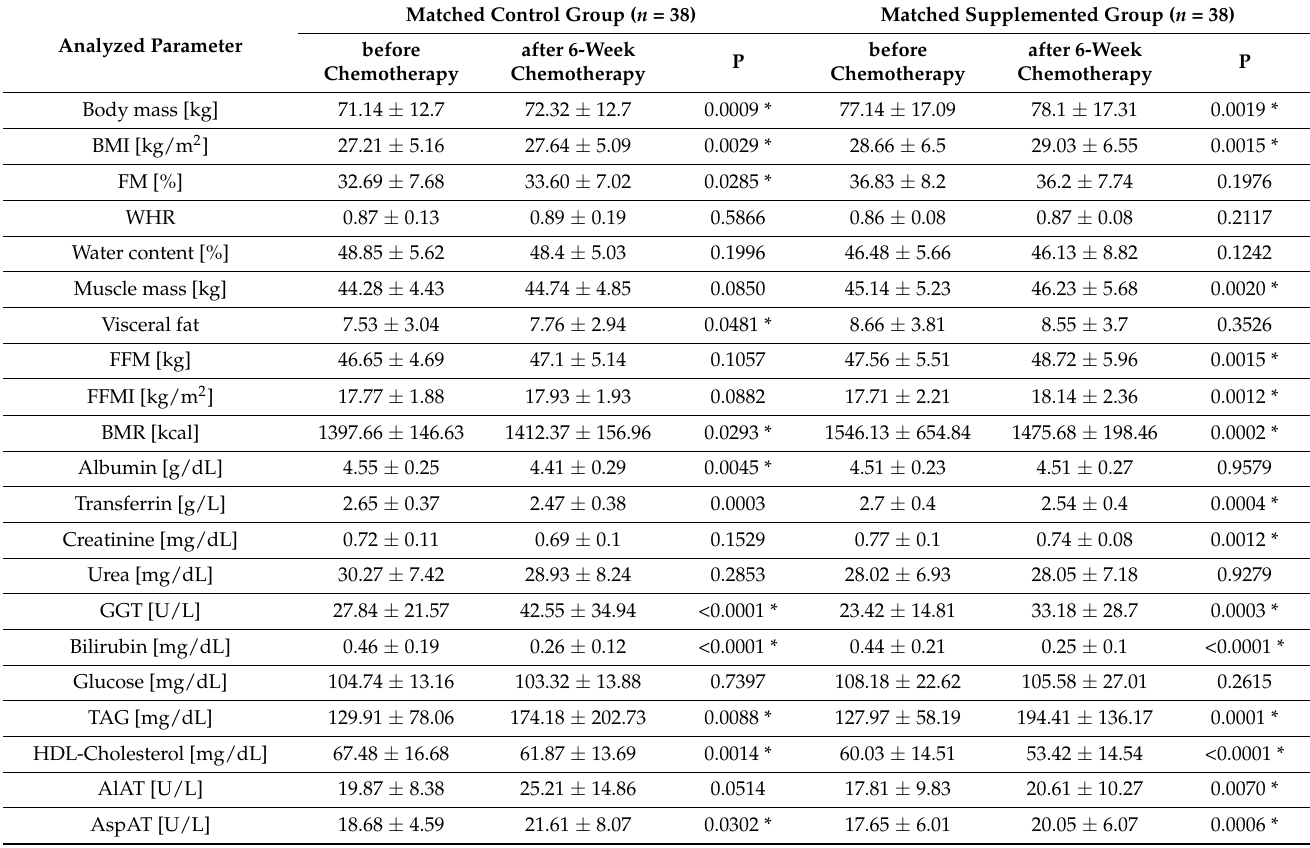
Table 2. The effect of ONS on anthropometric and biochemical parameters after six weeks of chemotherapy in the matched supplemented group and